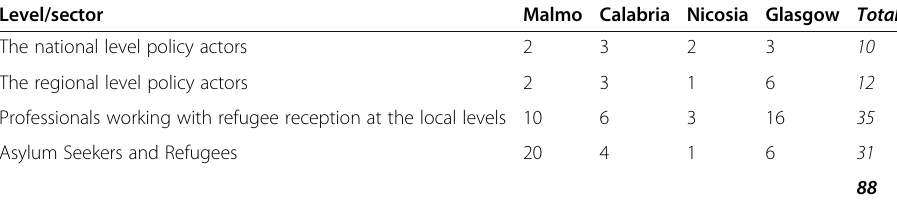
Table 1 Interviewees according to sector and case Level/sector